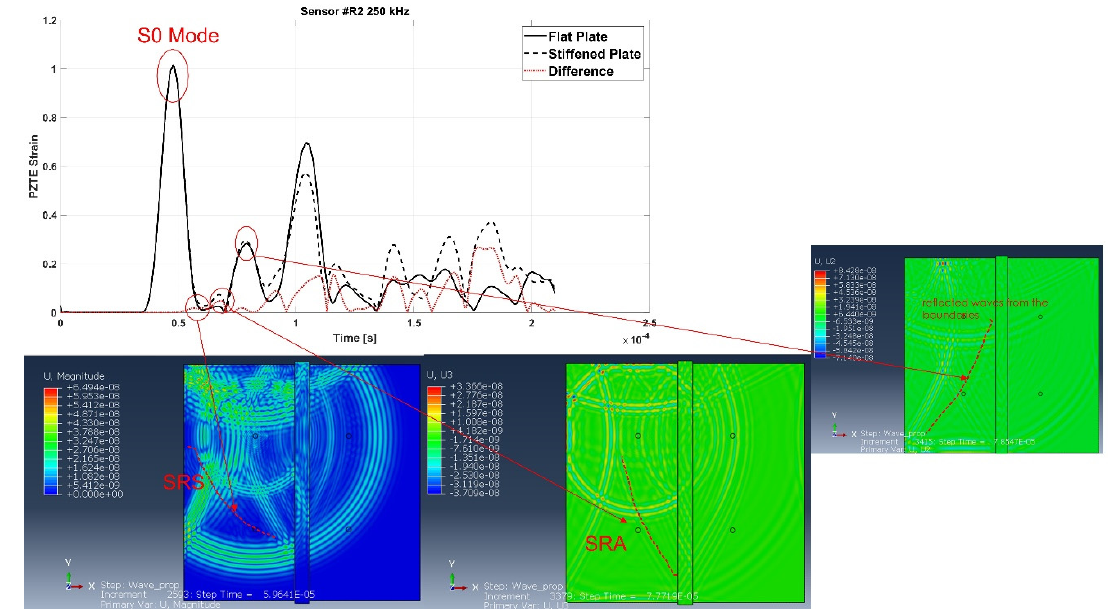
Figure 7. SRS and SRA modes at 250 kHz frequency detected by the R2 sensor – aluminum stiffened plate.